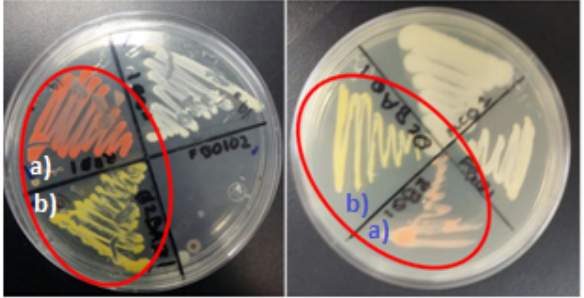
Figure 1 : Color variation in a) VNS13 and b) VNS4 strains isolated from native soil